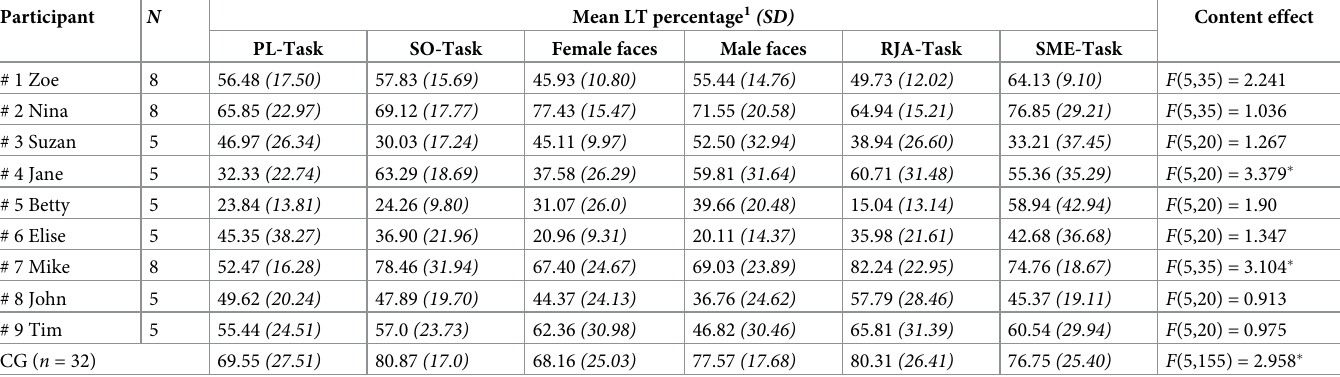
Table 4. Mean percentage (and standard deviation) of looking times (LT) on each of the 6 tasks composing a session of both the nine PIMD participants and the control group, and statistical analyses testing the main effect of the content, using within-subject repeated measures ANOVAs. Participant N Mean LT percentage 1 (SD) Content